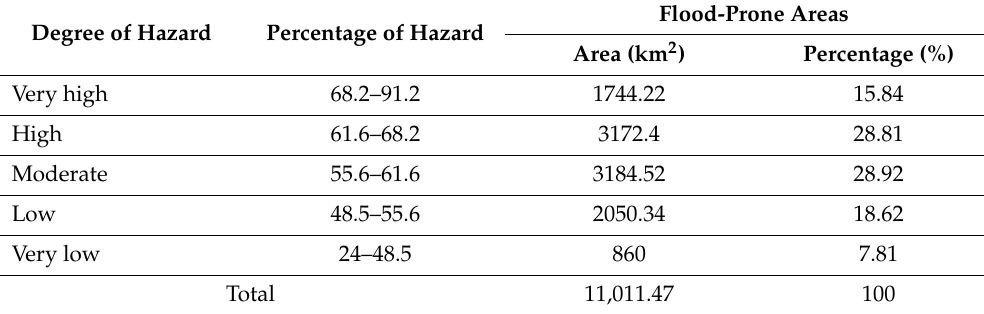
Figure 12. Degrees of flood hazard for drainage basins affecting the Al-Shamal train pathway in Al-Qurayyat city in 2020. Table 19. Degrees of flood hazard in the study area in